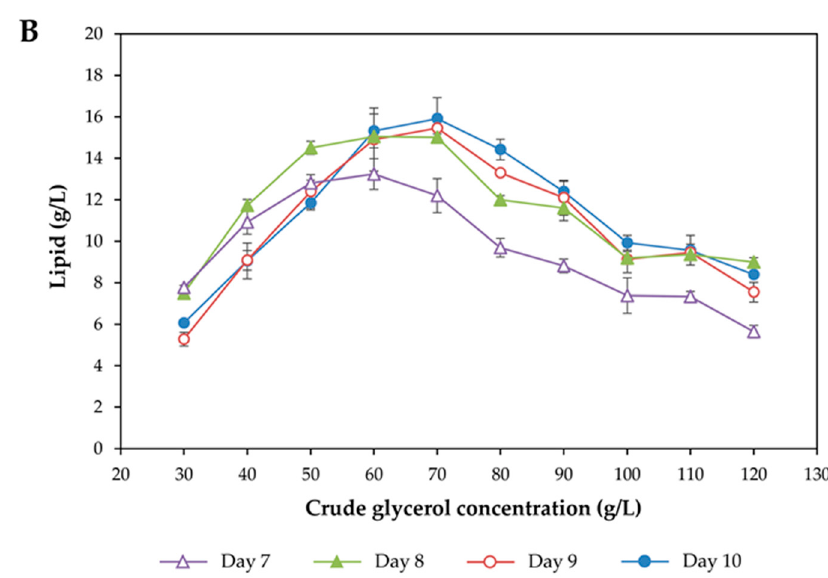
Figure 1. Effect of crude glycerol concentration on cell mass ( A ) and lipid ( B ) production by Rhodosporidiobolus fluvialis DMKU-SP314 in a shake flask culture at 28 °C and 150 rpm.